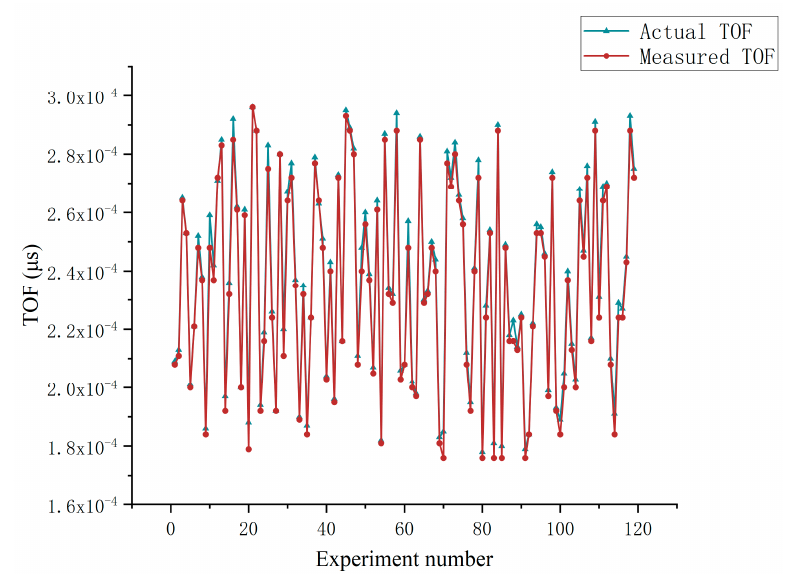
Figure 10. The distribution of measured TOF and actual TOF (Orange dots). Blue line denotes baseline where the measured TOF equals the corresponding actual TOF.